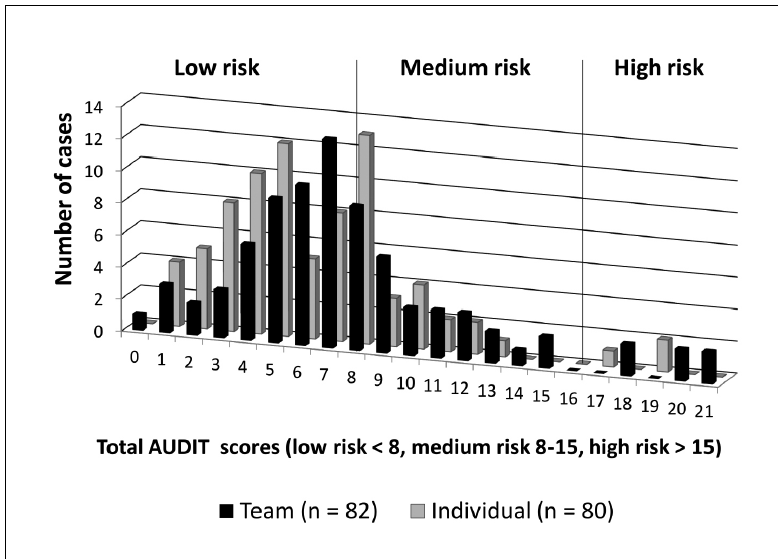
Figure. Distribution of the scores ob - tained on the Alcohol Use Disorders Identification Test (AUDIT) from team and individual